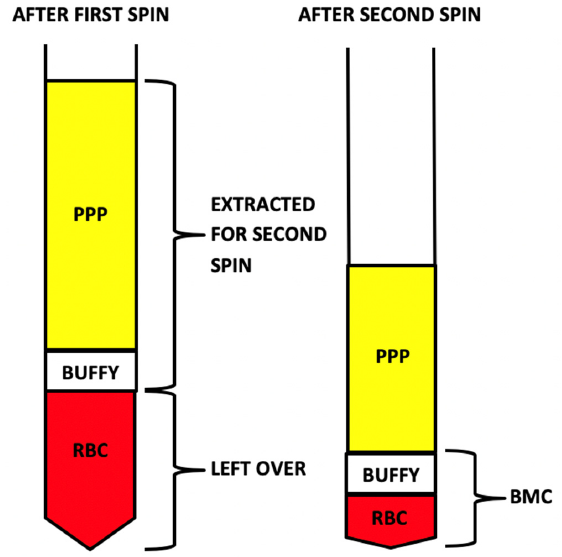
Figure 5. Demonstration of the bone marrow separation and resulting layers after the first and second centrifugation steps. Bone marrow concentrate (BMC); platelet-poor plasma (PPP); red blood